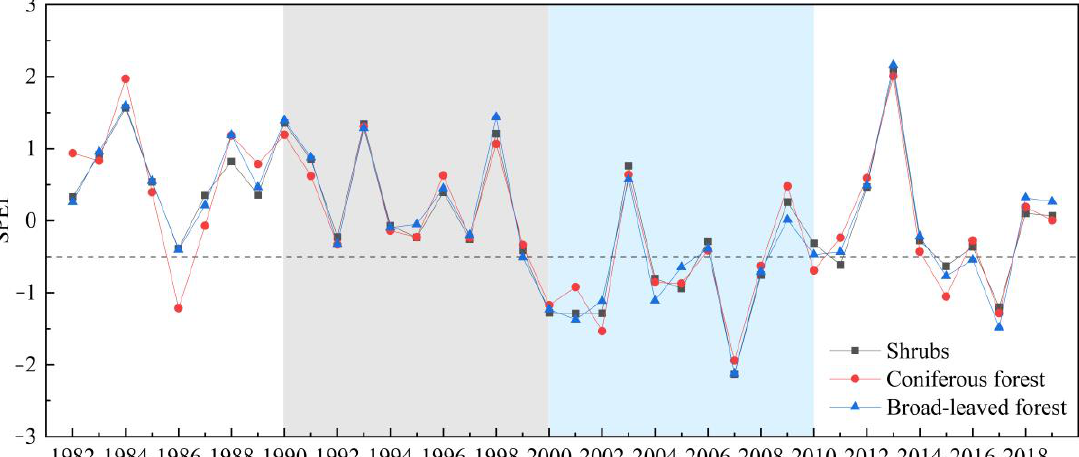
Figure 16. SPEI change trends of three forestlands in eastern Inner Mongolia. The meanings of the gray and blue backgrounds are the same as those in Figure 15. The black dotted line is the threshold for drought occurrence.